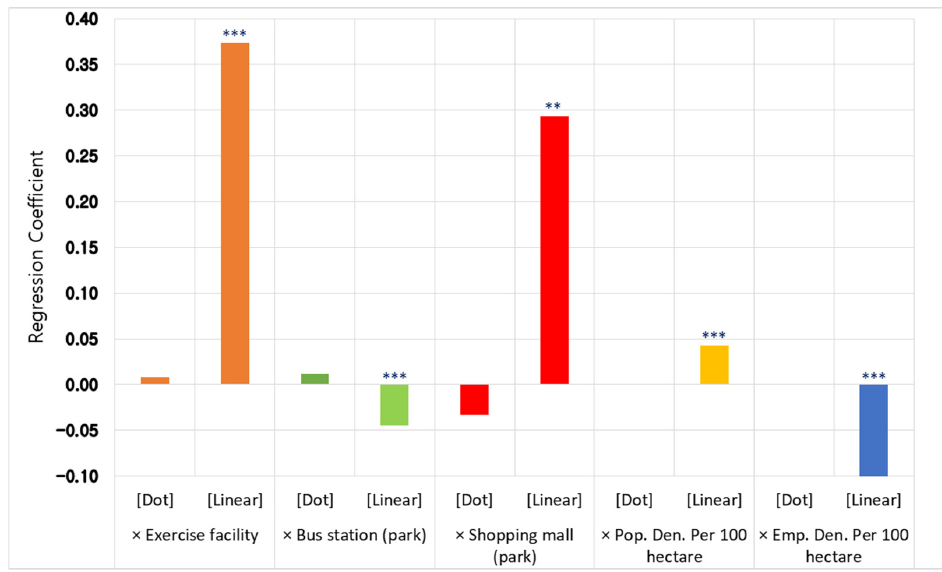
Figure 2. Regression coefficients for interaction terms by park type compared to the plane-type parks as a reference. (**: p < 0.01; ***: p < 0.001; [Dot] for point-type parks and [Linear] for line-type parks).